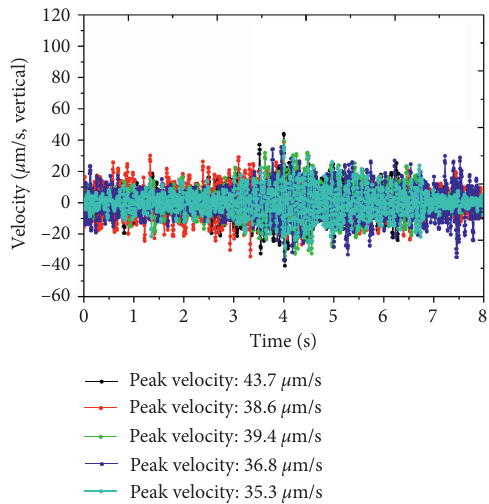
Figure 19: Velocity time histories of the surface vibrations of the actual antivibration